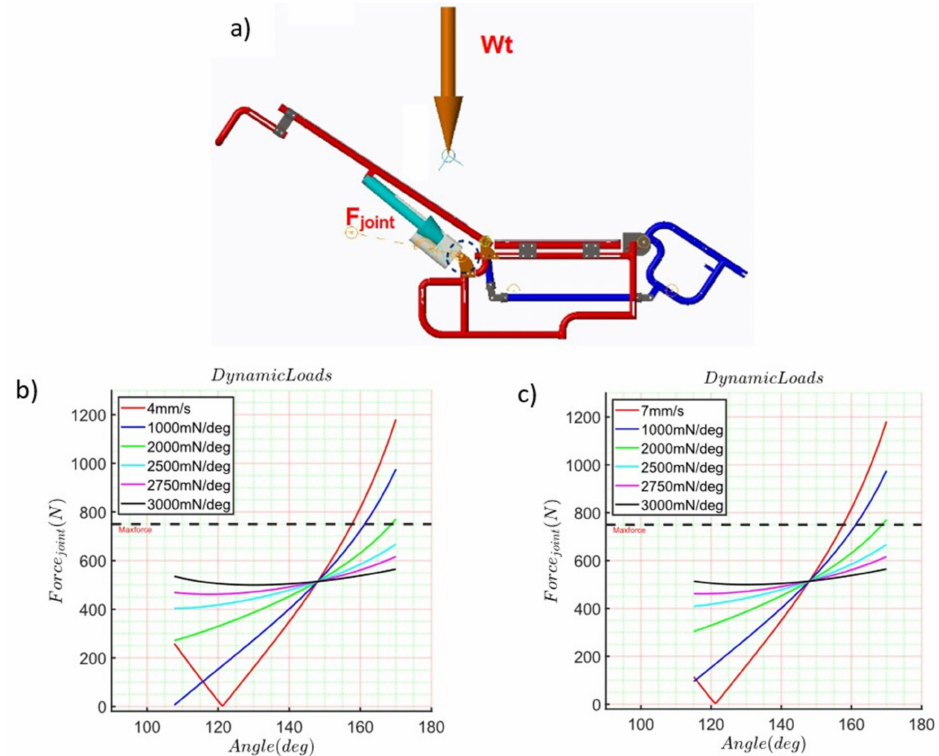
Figure 7. Computed results, ( a ) Dynamics wheelchair simulation; ( b ) Simulation at 4 mm/s, ( c ) Sim- ulation at 7 mm/s.